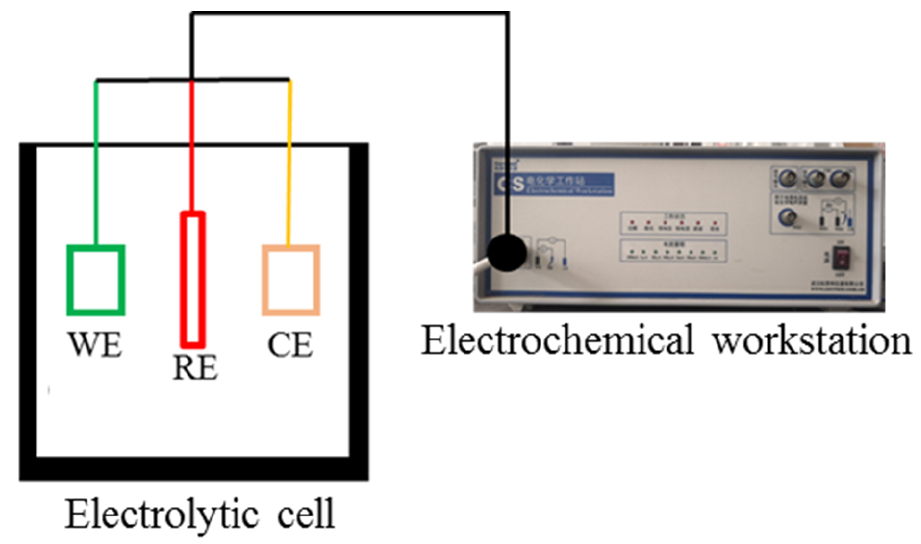
Figure 2. Schematic diagram of electrochemical hydrogen charging equipment.